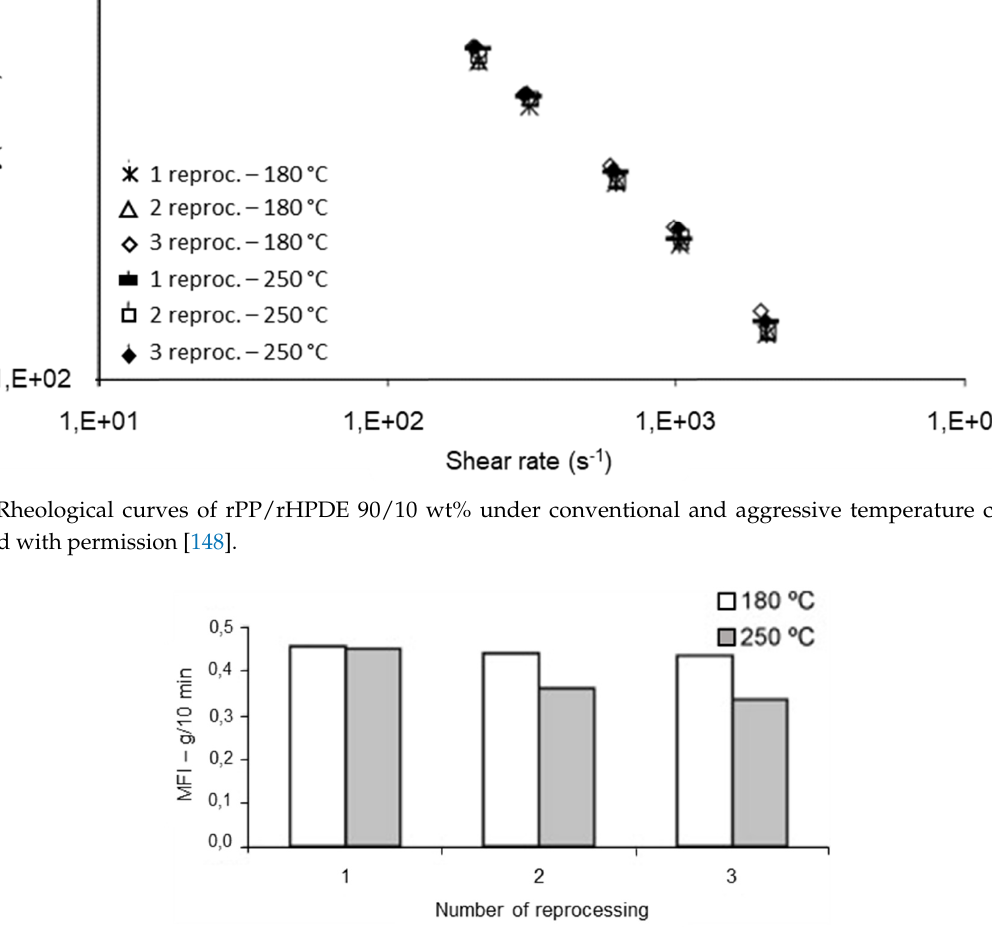
Figure 8. MFI of rPP/rHPDE 90/10 wt% blend reprocessed under conventional and aggressive tem- perature conditions. Reproduced with permission [148].